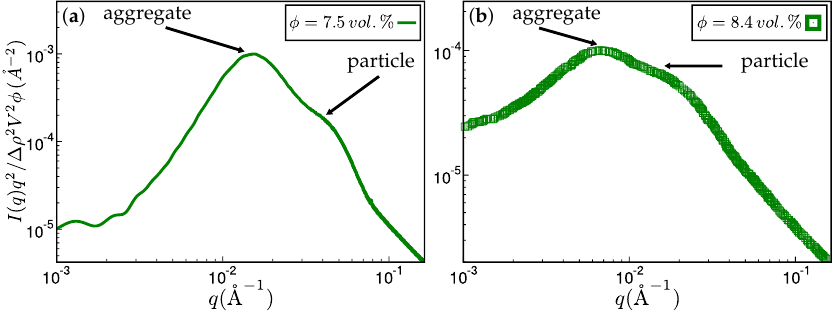
Figure 10. Approximate comparison between simulation and experiment. ( a ) Kratky representation of the scattered intensity obtained via simulation after 10 10 MC steps on a 256 × 256 × 256 lattice. The system has the same ingredients as in Figure 4. The filler volume fraction is φ = 7.5% and the temperature T = 160 ◦ C. The mean particle size quoted in the literature is (cid:104) R (cid:105) = 80 Å. The aggregate size corresponding to the aggregate peak is about 202 Å; ( b ) experimental scattering curve taken from Ref. [19] for styrene-butadiene rubber (SBR) filled with Zeosil 1165 MP. The filler volume fraction is φ = 8.4% and the temperature used to create this compound is T = 160 ◦ C. The particle and aggregate sizes according to the attendant peaks are 139 Å and 402 Å, respectively.